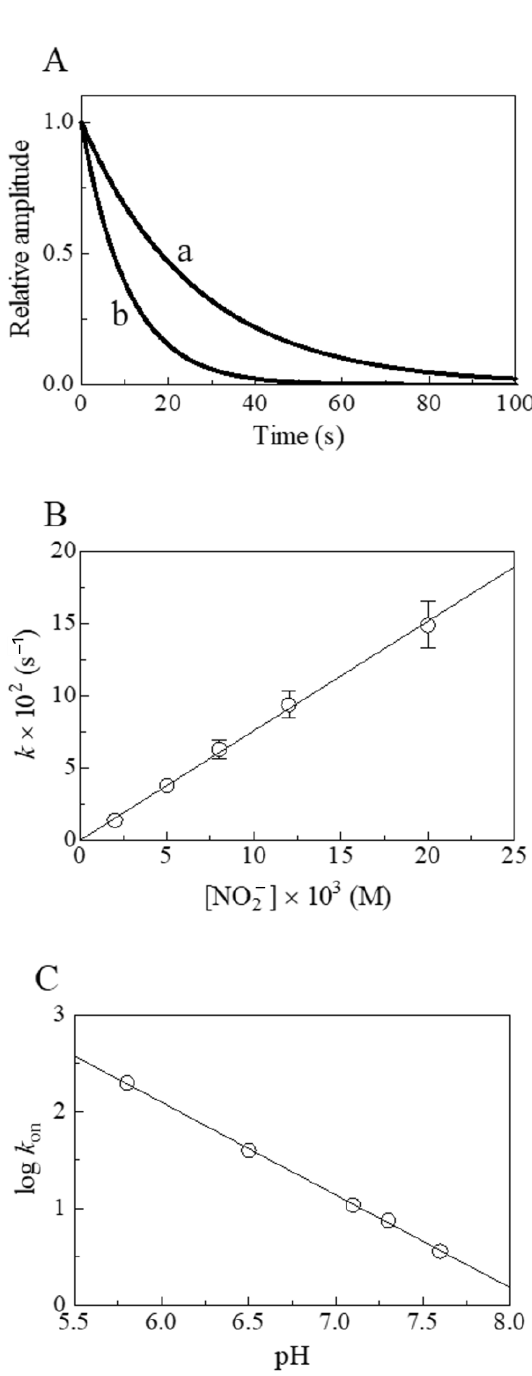
Figure 1. Nitrite reductase activity of Mt -Nb(II) at 20.0 °C. ( A ) Normalized averaged time courses for the NO 2 − -mediated conversion of Mt -Nb(II) to Mt -Nb(II)-NO at pH 7.3 in the presence of 5.0 × 10 −3 M (trace a) and 1.2 × 10 −2 M (trace b) NO 2 − . The time course analysis according to Equation (3) allowed the determination of the following values of k obs : 3.8 × 10 −2 s −1 (trace a) and 9.4 × 10 −2 s −1 (trace b). ( B ) Dependence of k obs on the NO 2 − concentration for Mt -Nb(II) nitrosylation, at pH 7.3. The solid line was calculated according to Equation (4) with the following value of k on = 7.6 ± 0.8 M −1 s −1 . ( C ) pH-dependence of log k on for the NO 2 − -mediated conversion of Mt -Nb(II). The value of the slope of the continu ous line is −0.96 ± 0.1 0. Where not shown, standard deviation is smaller than the symbol.